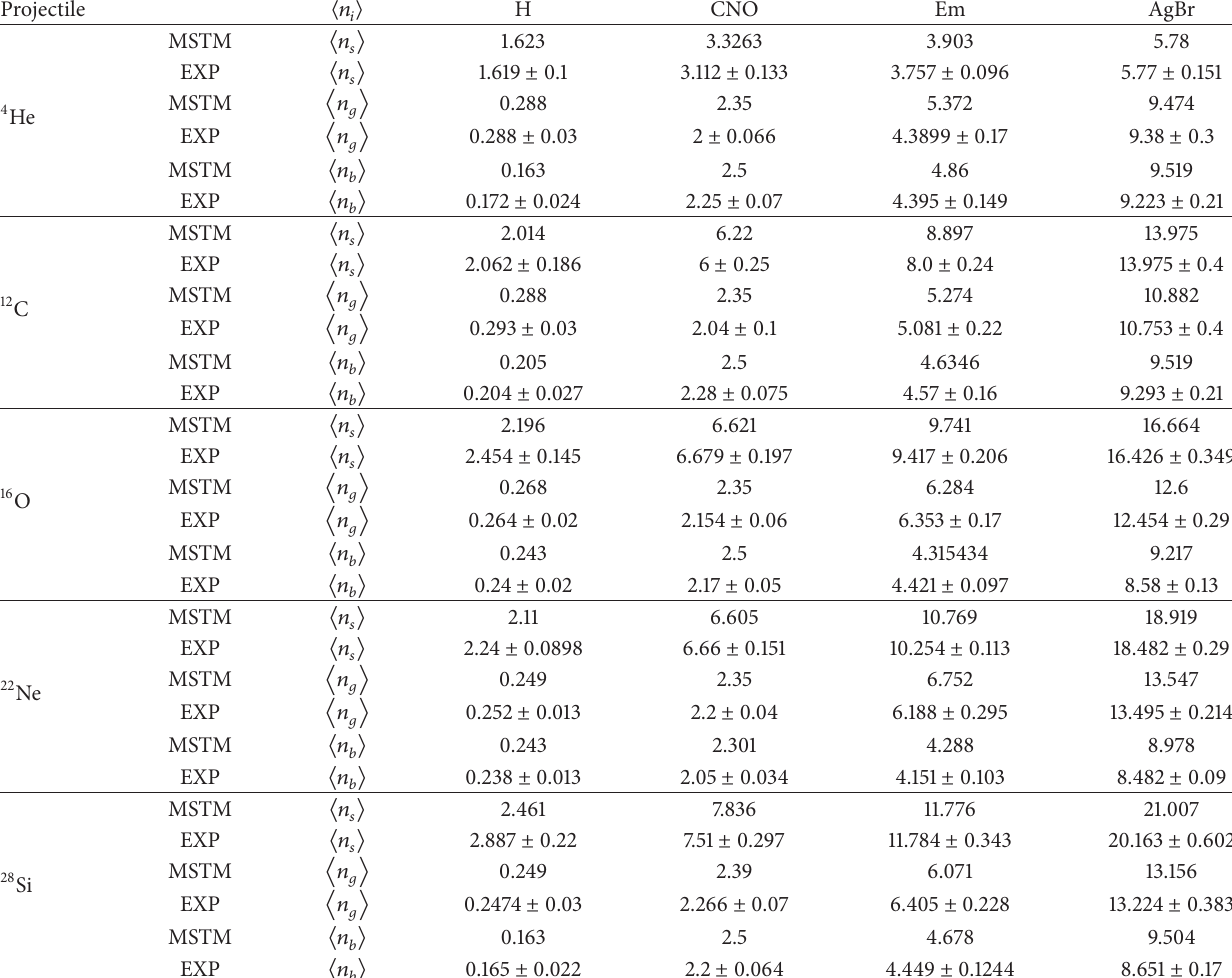
Table 1: The average multiplicities of the charged secondary particles emitted in 4 He-, 12 C-, 16 O-, 22 Ne-, and 28 Si-Em interactions and those emitted in the interactions with the different groups of target nuclei (H, CNO, Em, and AgBr) compared with those obtained by the model.